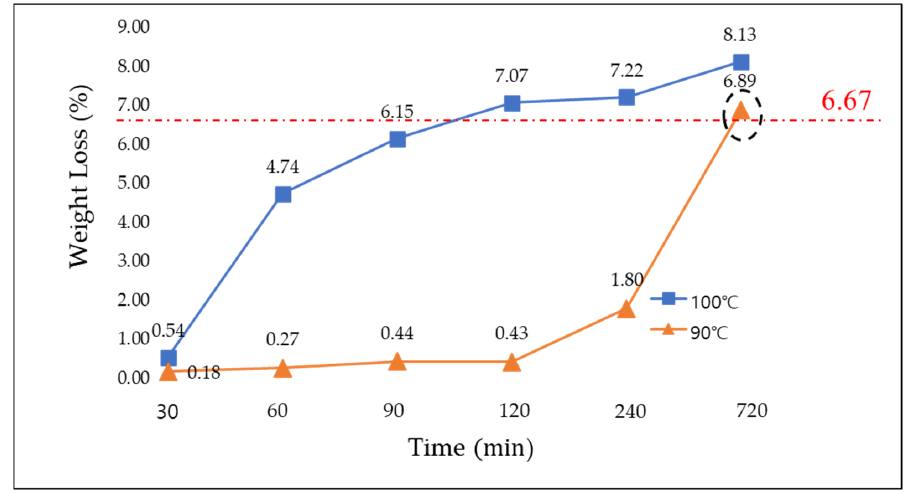
Figure 2. Weight losses of APT with drying time at 90 °C and 100 °C.